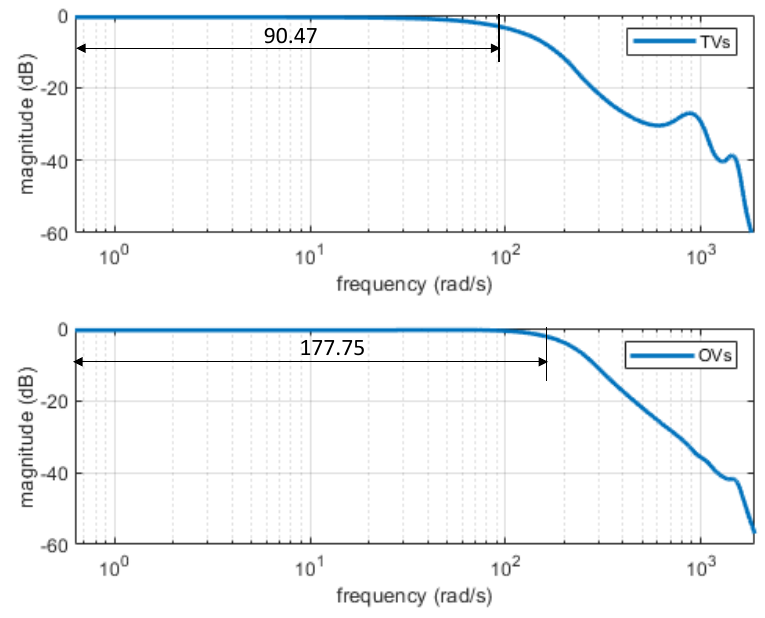
Figure 8. Magnitude plots of G p with traditional and optimal parameters.